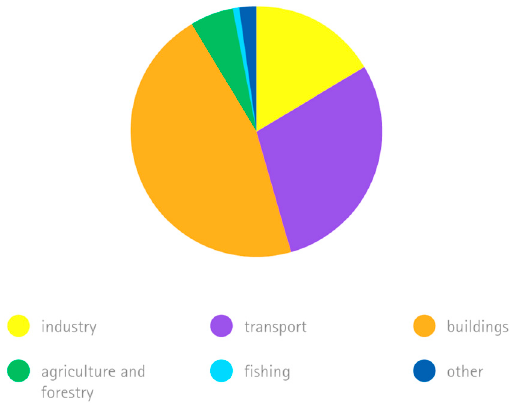
Figure 1. Danish energy consumption by sector in 2012 [30].